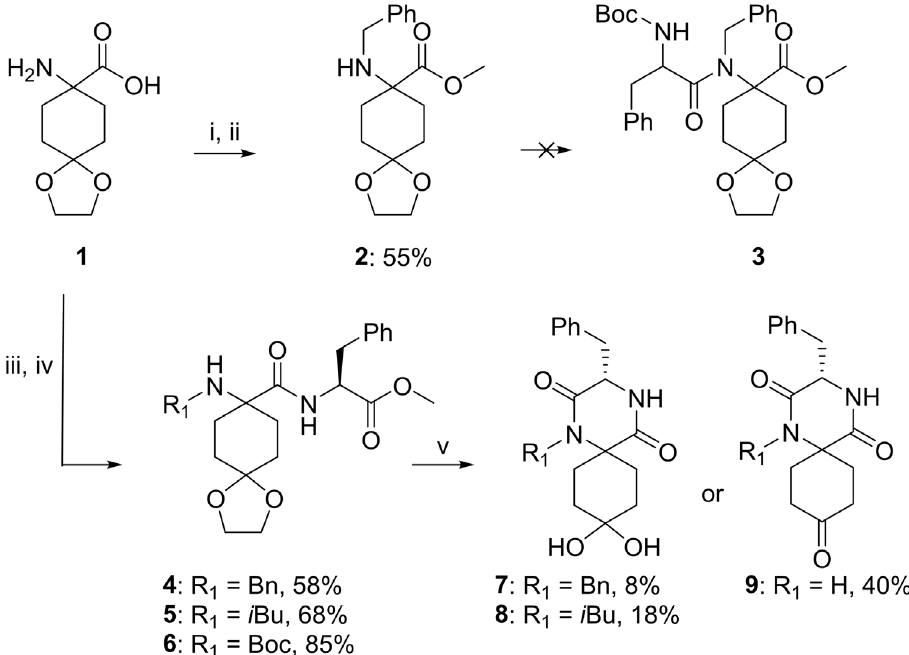
Fig 4. Synthesis of spiro-DKPs 7 – 9. Reagents and reaction conditions: i) PhCHO (1.2 eq.), Et 3 N (1.2 eq.), NaCNBH 3 (1.0 eq.), MeOH, r.t. ii) (CH 3 ) 3 SiCHN 2 (6.4 eq.), MeOH/toluene (1:3), r.t. iii) 4 or 5 : R 1 CHO (1.2 – 1.5 eq.), Et 3 N (1.2 eq.), NaCNBH 3 (1.0 eq.), MeOH, r.t. iv) Phe-OMe (2.0 eq.), HATU (2.0 eq.), DIPEA (12 eq.), DMF, 60°C, 30 min. 6 : iii) Boc 2 O, 3M NaOH and 1,4-dioxane (1:2, pH~12), r.t. iv) Phe-OMe (2.0 eq.), HATU (2.0 eq.), DIPEA (6.0 eq.), DMF, 60°C, 30 min. v) 4 : water, MW, 160°C, 30 min; 5 : HCl (1M, aq.)/acetone (1:1), 55°C, 72 h 6 : water, MW, 160°C, 90 min.